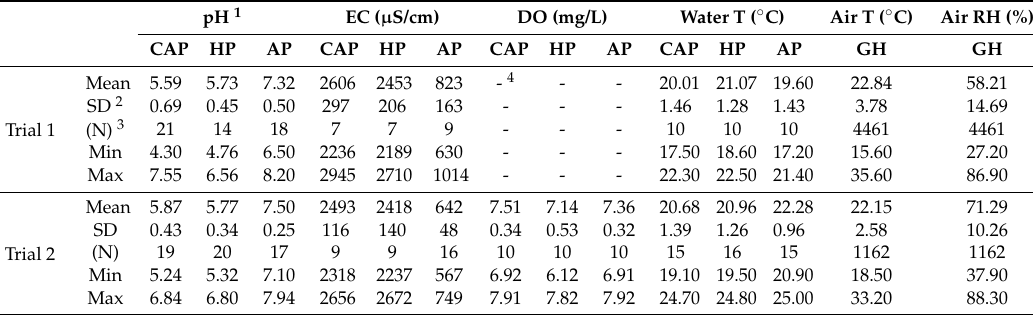
Table 3. Growth environmental conditions for trial 1 and